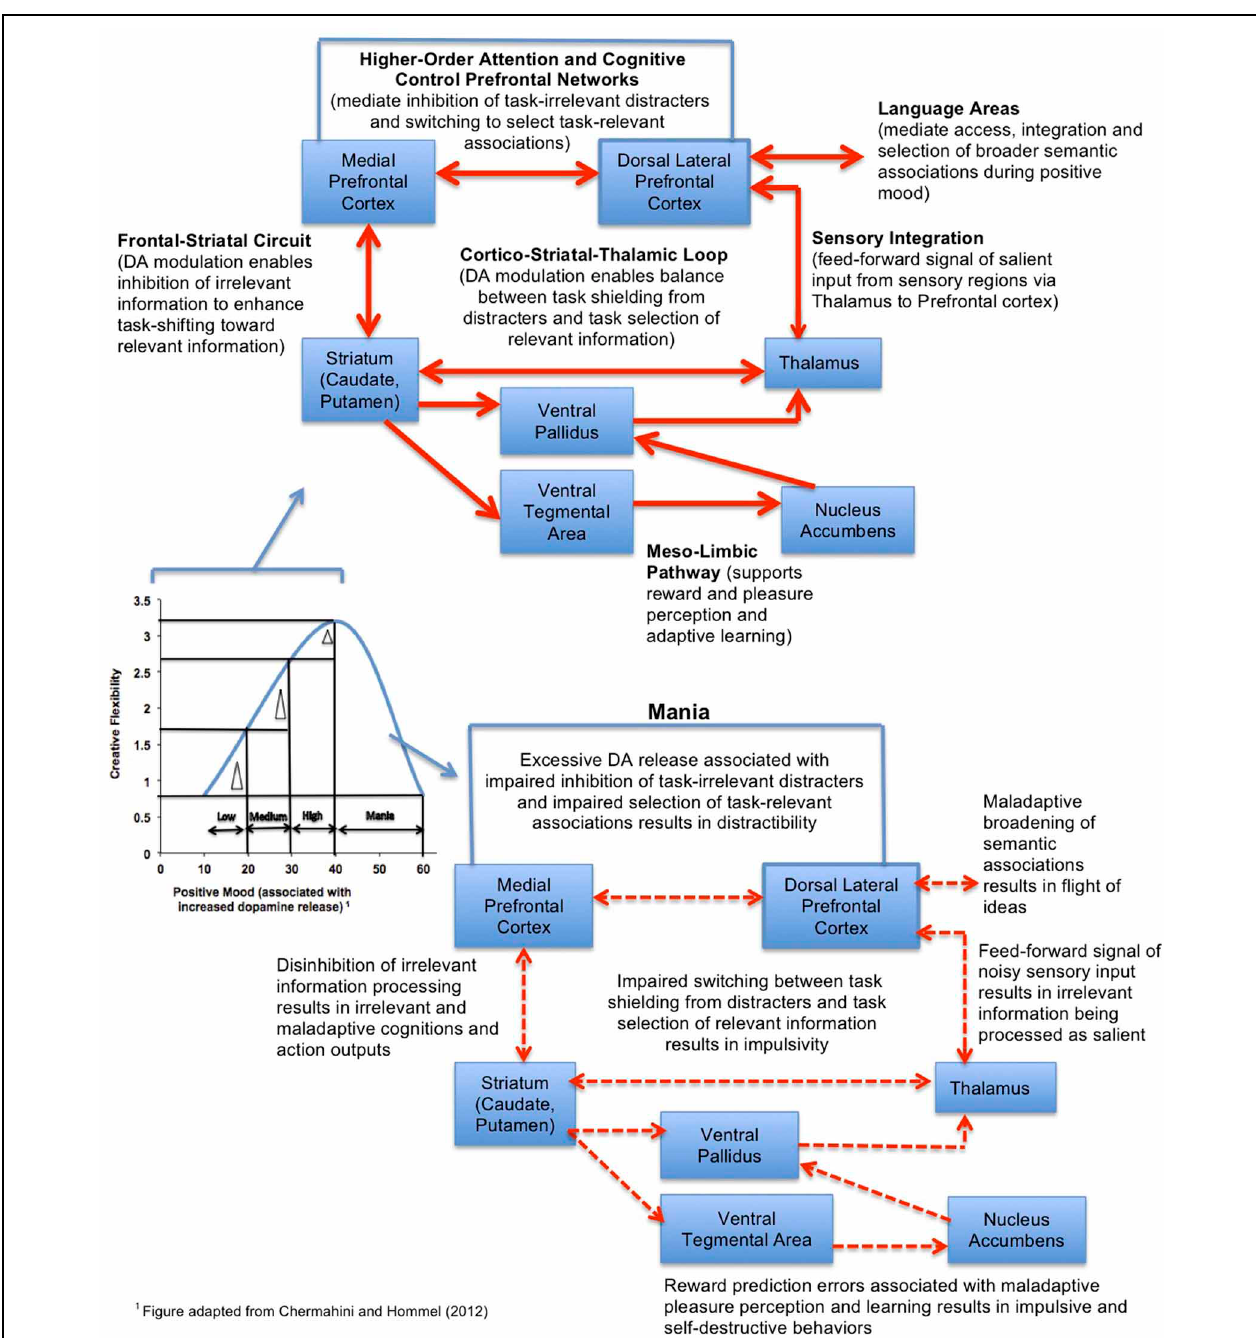
FIGURE 5 | Model of the neural system interactions mediating the effect of positive mood on creative cognition. The model predicts that the largest gains in cognitive flexibility (indicated by the delta triangle) induced by